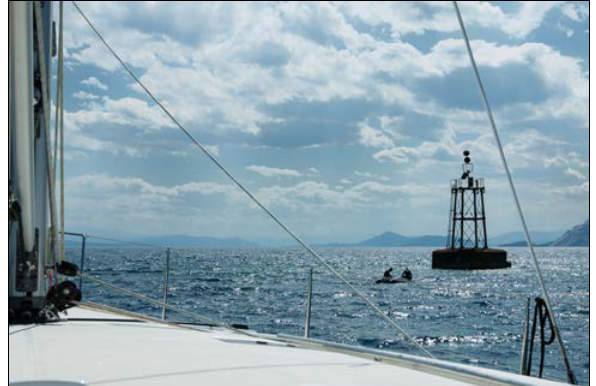
Figure 2. Lefteris reef with its modern navigation light